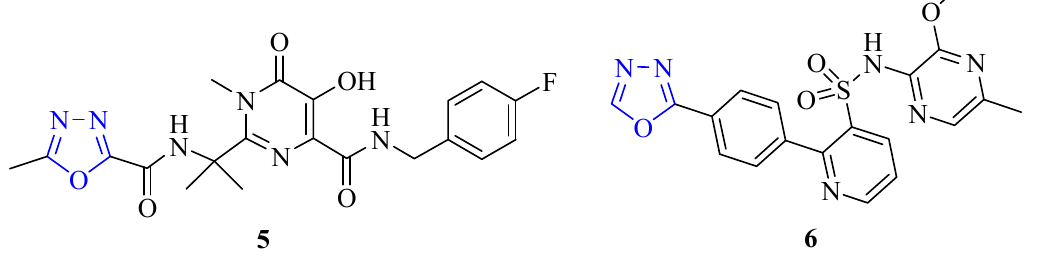
Figure 2. Structures of raltegravir and zibotentan, drugs that are in late stage clinical